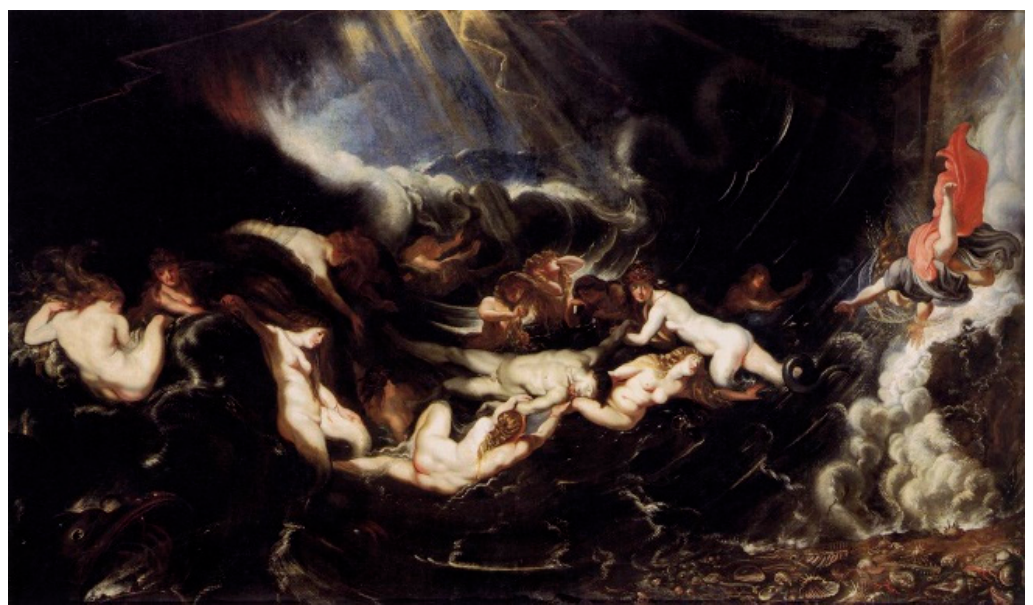
Figure 1. Peter Paul Rubens, Hero and Leander, ca. 1608, oil on canvas, Gemäldegalerie Dresden), artwork in the public domain.